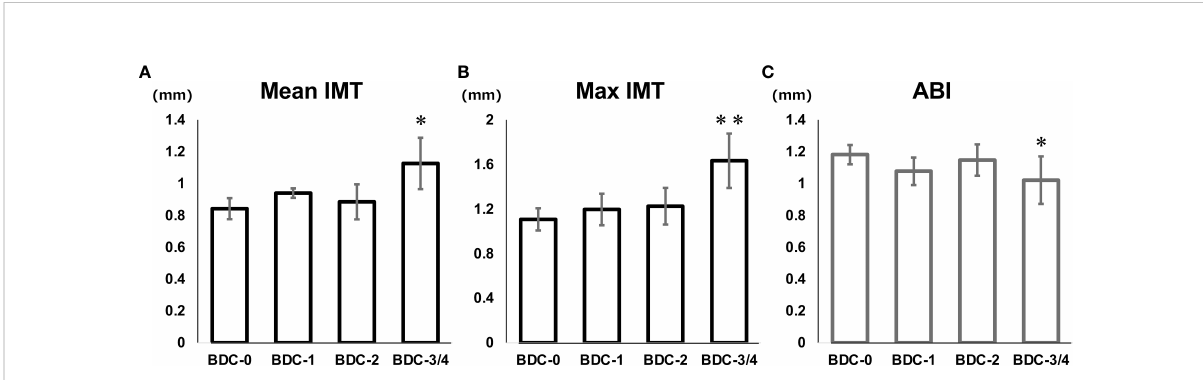
FIGURE 4 Relationship of Baba ’ s diabetic neuropathy classi fi cation (BDC) with arteriosclerosis. (A) Correlation between BDC and mean IMT. (B) Correlation between BDC and max IMT. (C) Correlation between BDC and ABI. Data are presented as mean and standard deviation (SD). *P<0.05, **P<0.005 with ANOVA adjusted for age, gender, duration of disease, smoking history, HbA1c, BMI, hyperlipidemia medications, and hypertension